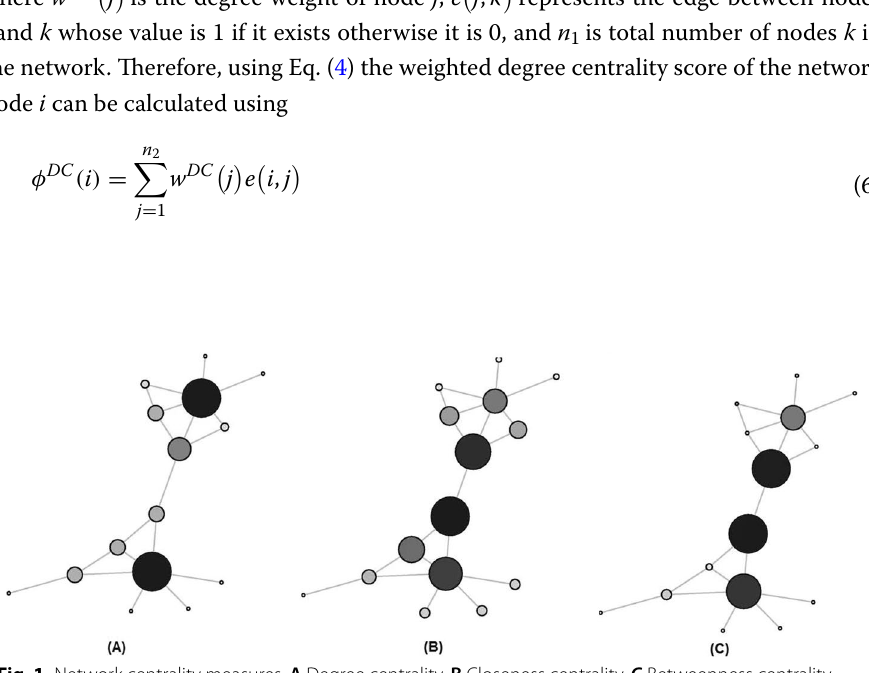
Fig. 1 Network centrality measures. A Degree centrality, B Closeness centrality, C Betweenness centrality. The darkness and the size of each node is proportional to its centrality